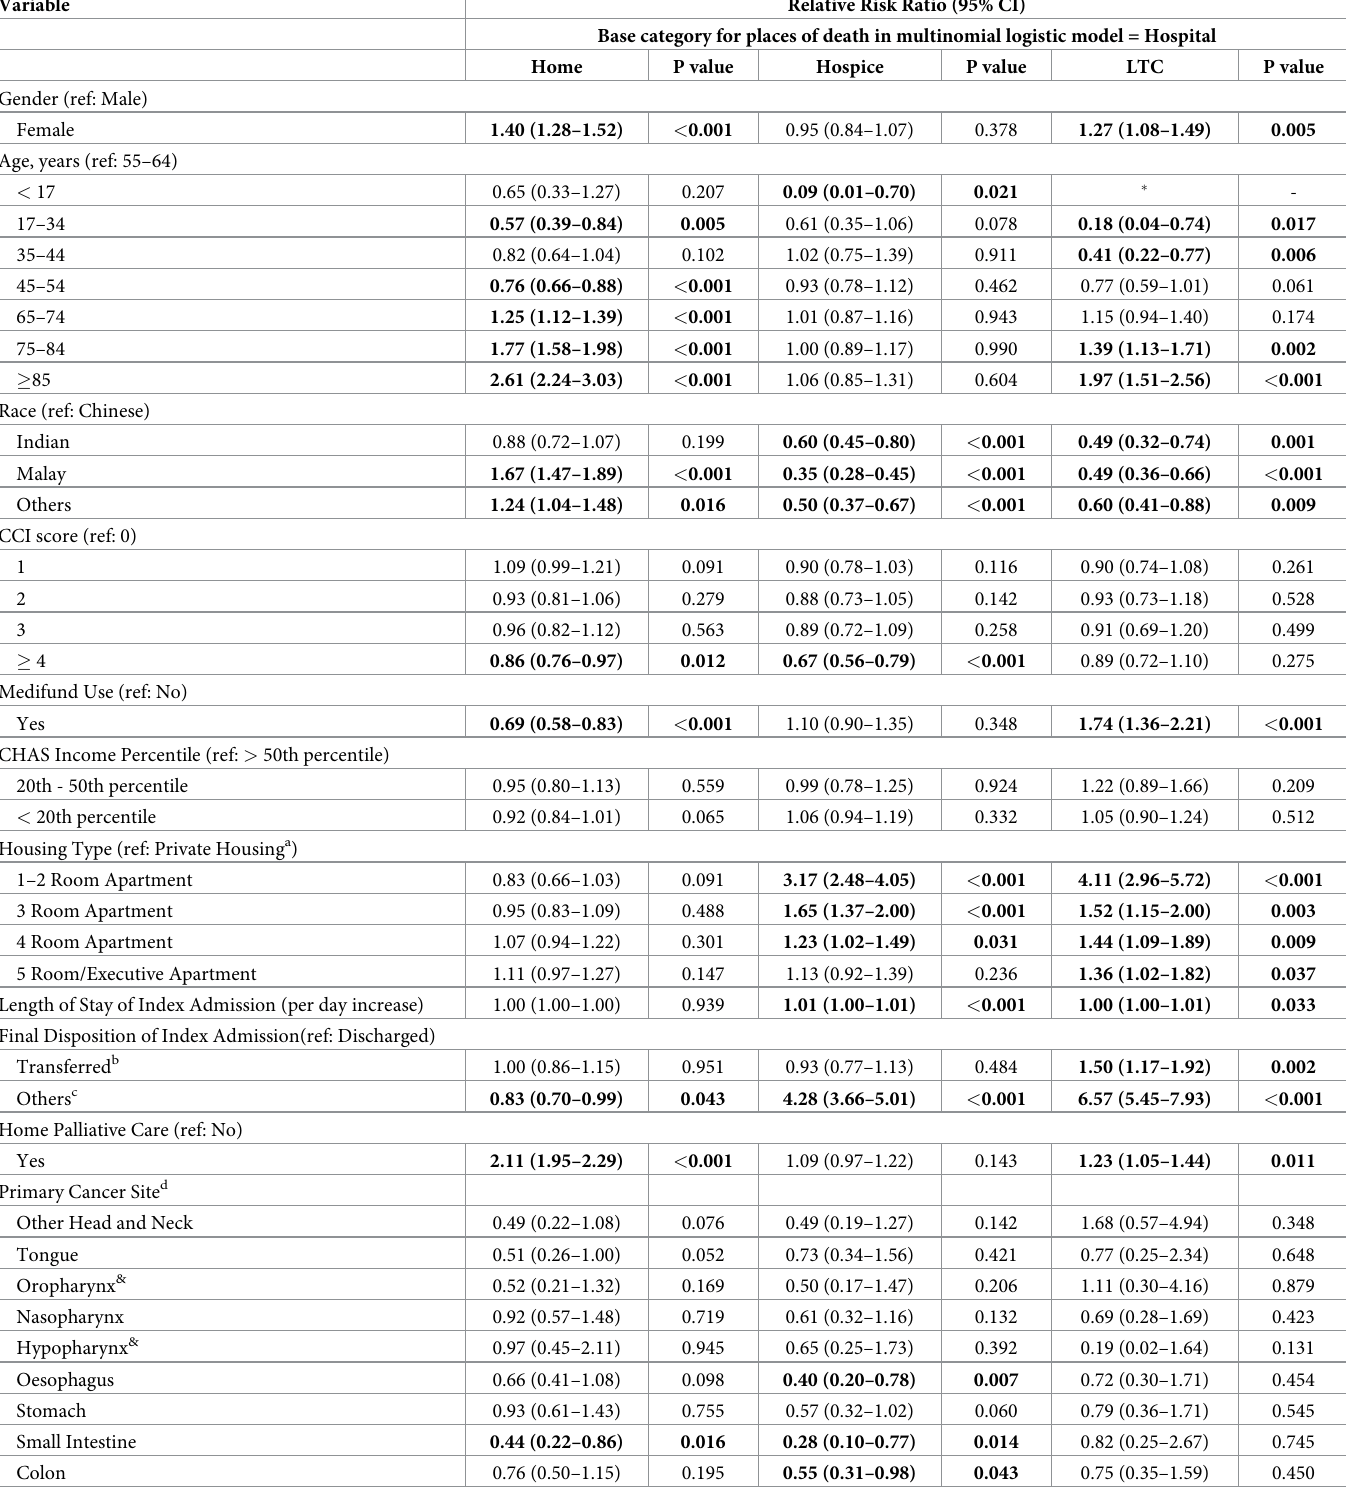
Table 2. Association of places of death with sociodemographic and clinical